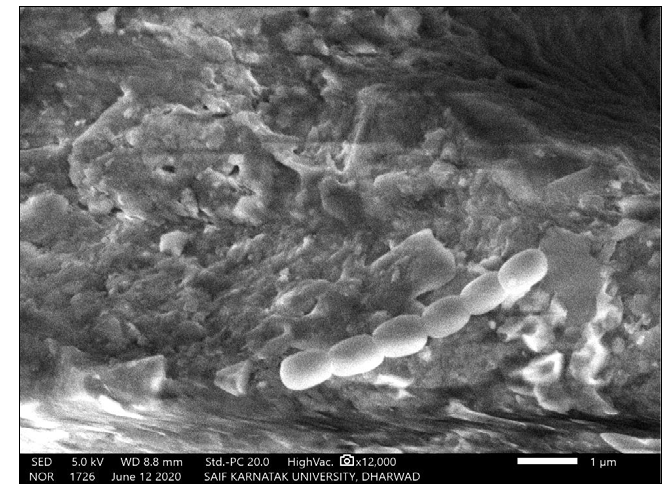
Fig.9. SEM image of